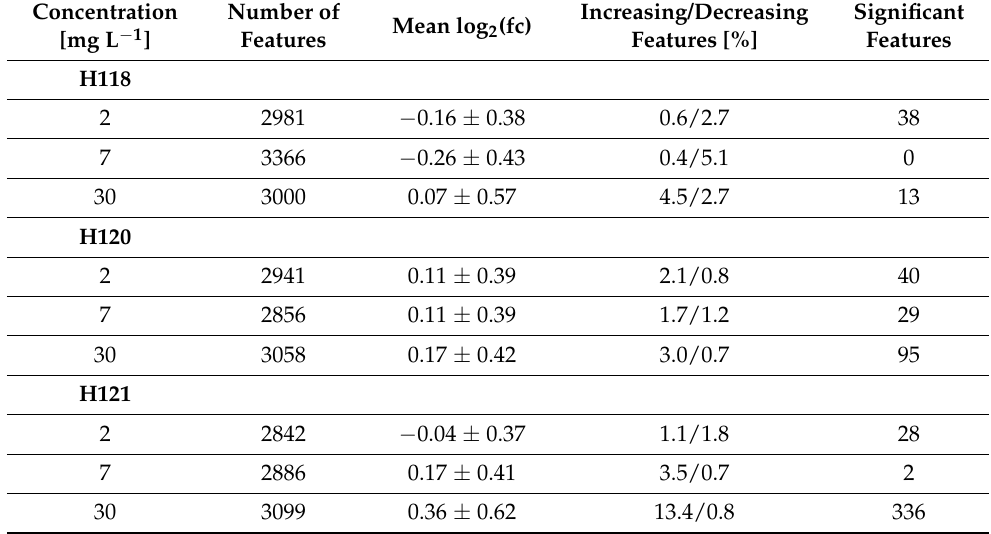
Table 2. Means and standard deviations of log 2 (fc) values for the non-target features in the positive ionization mode. H118, H120 and H121 are the laboratory names of the different PAC types (Table 3) which were tested for surface water treatment at three different